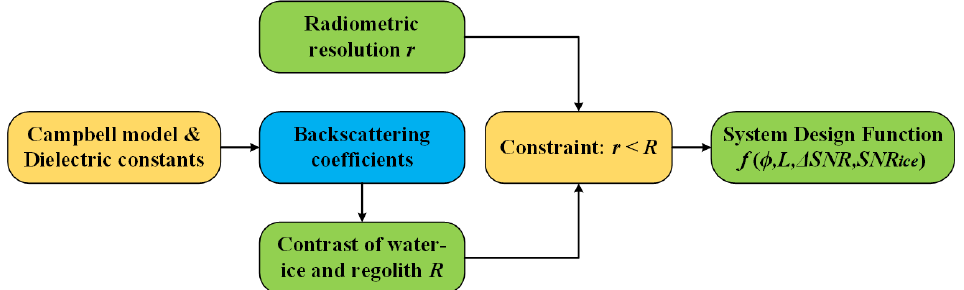
Figure 1. The main flow of the newly defined SAR system function for lunar water ice exploration is presented based on the Campbell model and the requirement of SAR radiometric